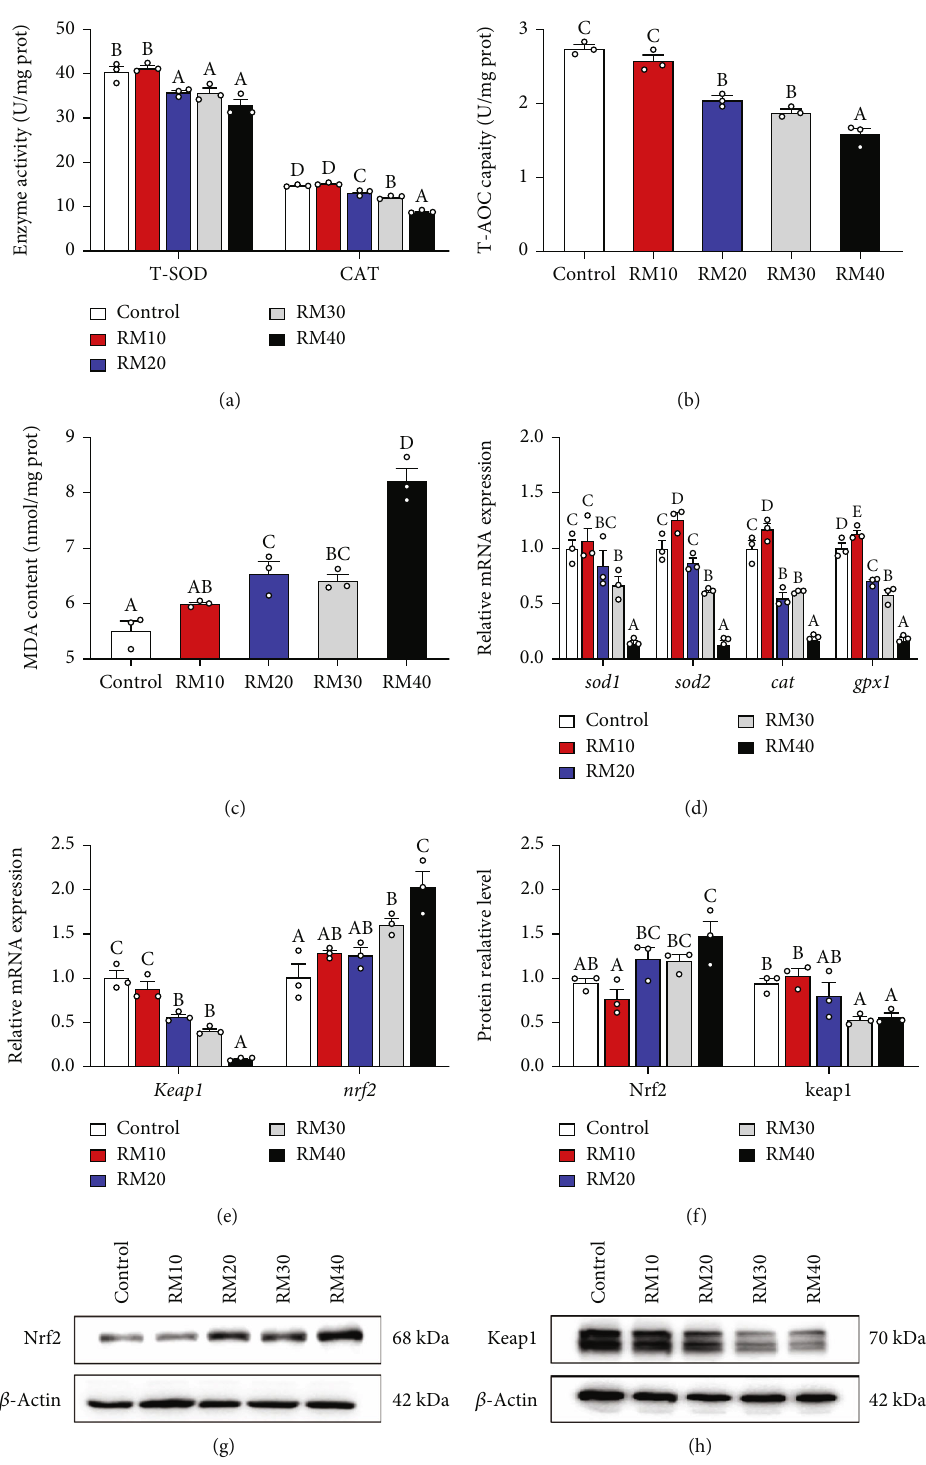
Figure 3: E ff ects of fi sh meal replacement by mixed plant protein sources on oxidative stress and antioxidant response in the liver of yellow cat fi sh. (a) Activity of oxidative enzymes. (b) Total antioxidant capacity. (c) MDA content. (d) Relative mRNA expression of oxidative stress-related genes. (e) Relative mRNA expression of Nrf2 and Keap1. (f) Protein relative level of Nrf2 and Keap1. (g) Western blot of Nrf2. (h) Western blot of Keap1.Values are means ± S : E : M . ( n = 3 ). Letters (a – d) denote signi fi cance P < 0 : 05 (One-way ANOVA, Duncan post hoc